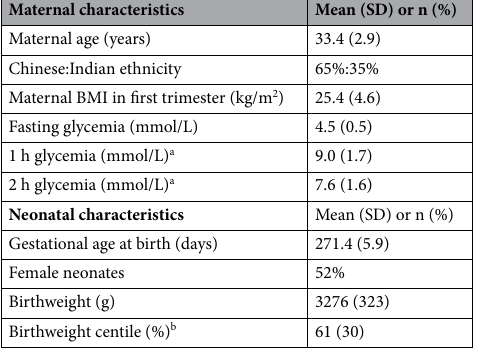
Table 3. Clinical characteristics of study population. a In mid-gestation following 75 g OGTT. b Standardized for sex and gestational age using local references 65,66